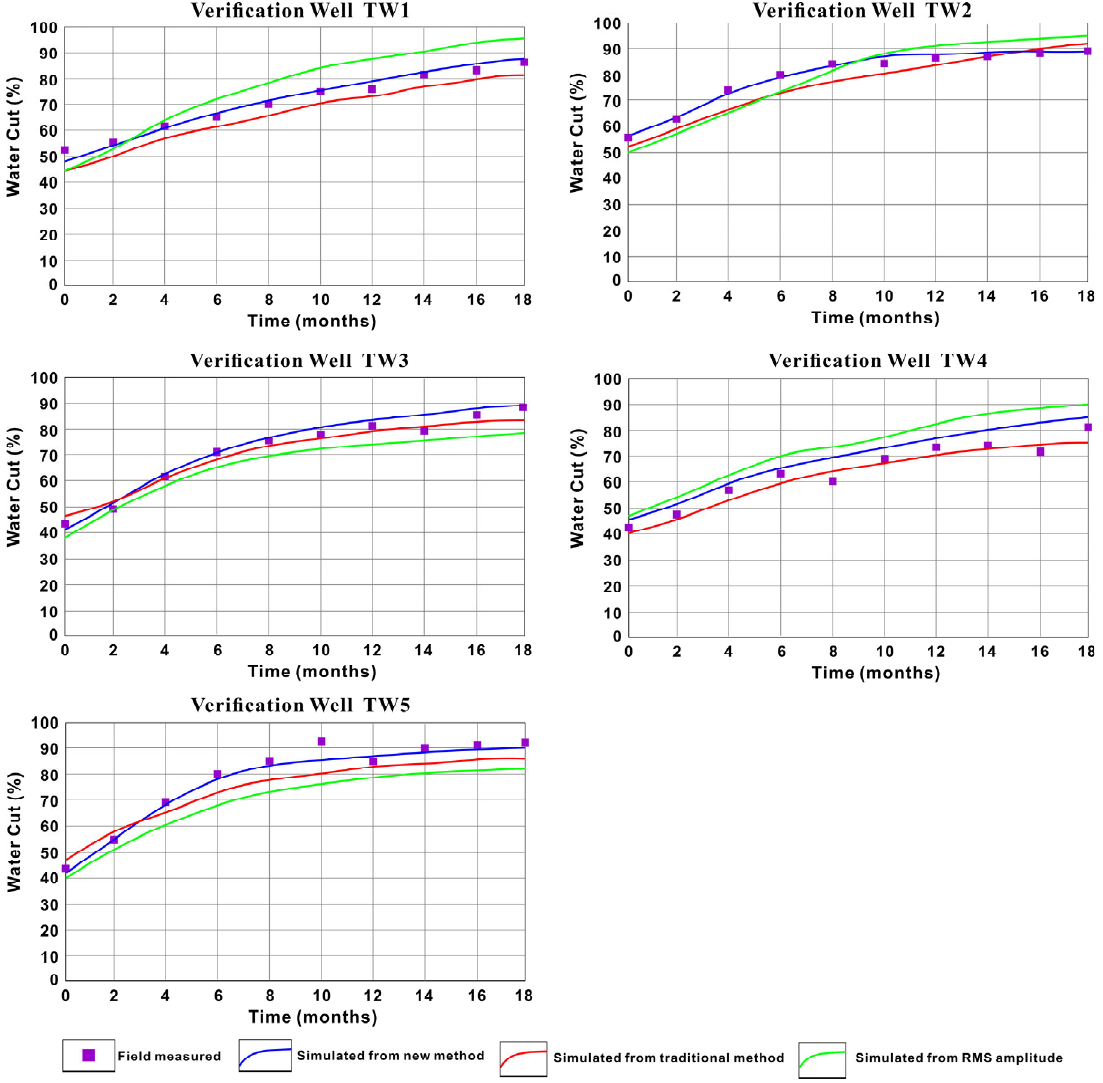
Figure 17. Comparison of water cut data of five typical verification wells obtained from field measurements and simulated from reservoir model established by the new method, traditional method, and RMS amplitude in the studied area.